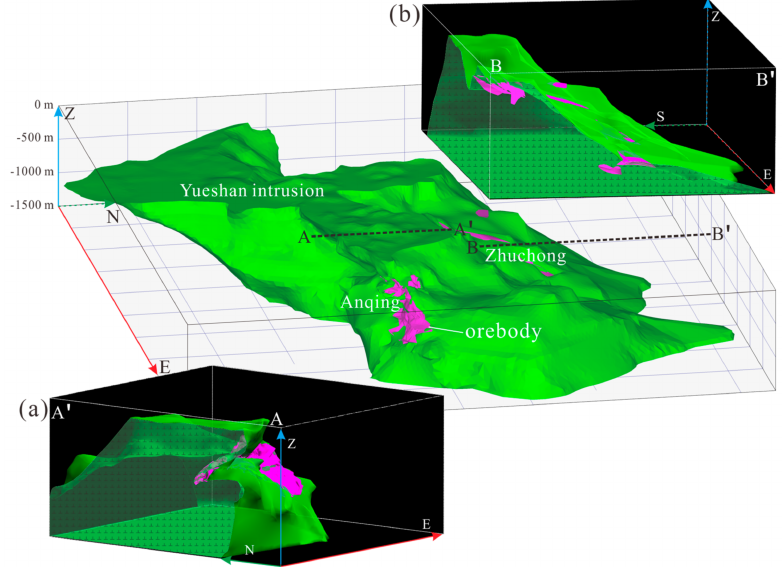
Figure 4. Spatial association of the Yueshan intrusion with orebodies, ( a ) for the Anqing deposit; and ( b ) for the Zhuchong